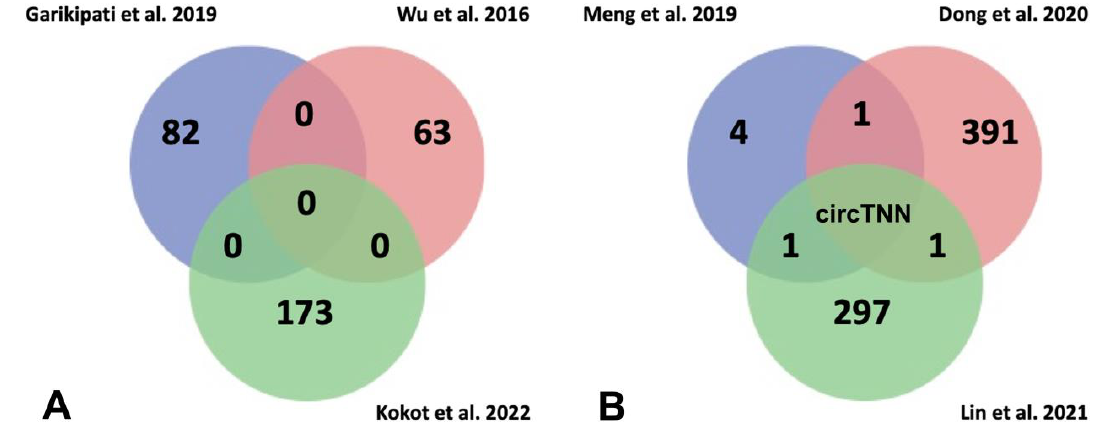
Figure 4. ( A ) Venn diagram for analysis of commonly deregulated circRNAs related to heart failure in Garikipati et al., 2019 [117], Wu et al., 2016 [118], and Kokot et al., 2022 [119] studies. It has been evidenced that several circRNAs are deregulated in HF; however, there are not any commonly deregulated circRNAs among the three studies considered in this review. ( B ) Venn diagram for analysis of commonly deregulated circRNAs related to risk factors to heart failure in Meng et al., 2019 [120], Dong et al., 2020 [121] and Lin et al., 2021 [122]. The comparison between them showed that circTTN is deregulated in all studies suggesting a role of possible biomarker of HF. Several authors have analysed circRNA transcriptomics from myocardial